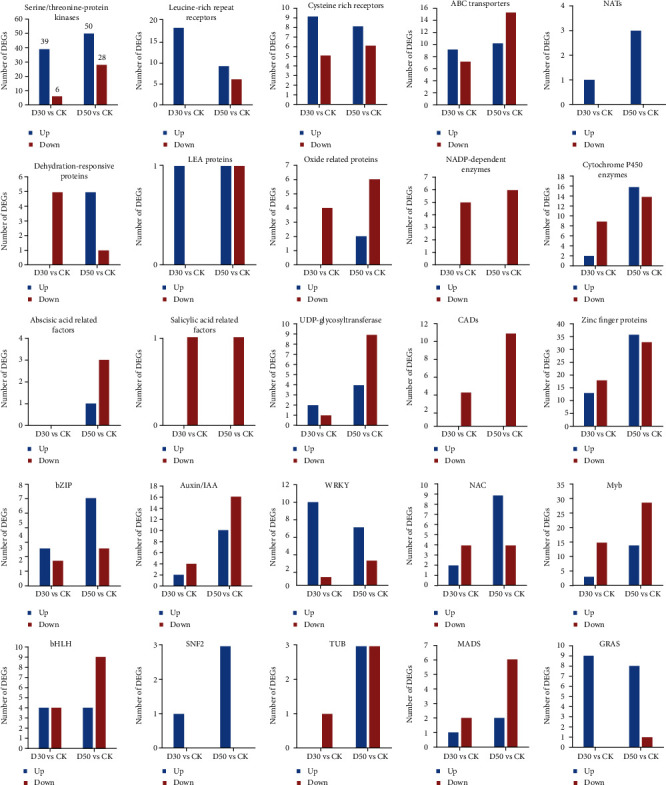
The number of genes encoding related factors in cotton plants.